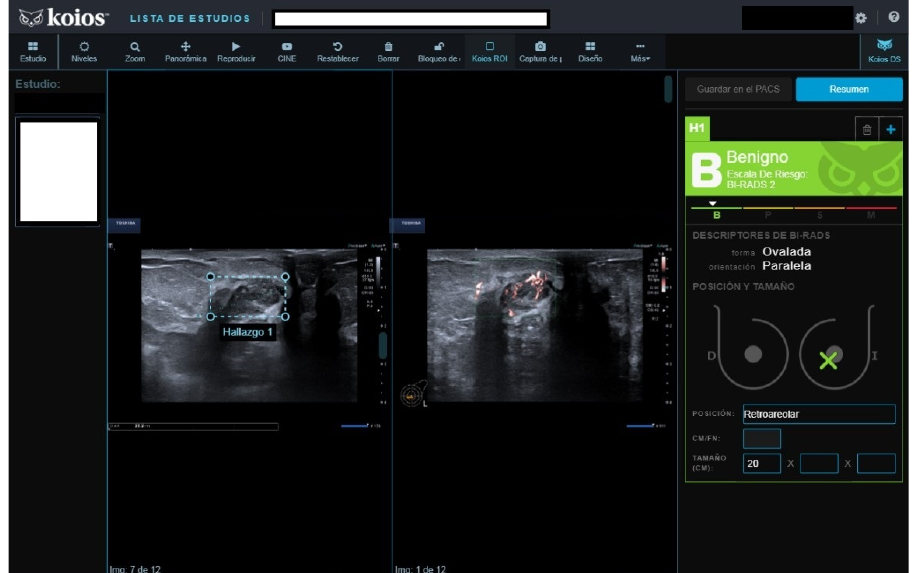
Figure 7. Rated B4c (B4b in mammography), KOIOS rendered a Kbe category. Pathology: chronic and acute inflammation. No signs of malignancy. Patient refused further surgery. BUS 2 years later found no significative residual lesion.